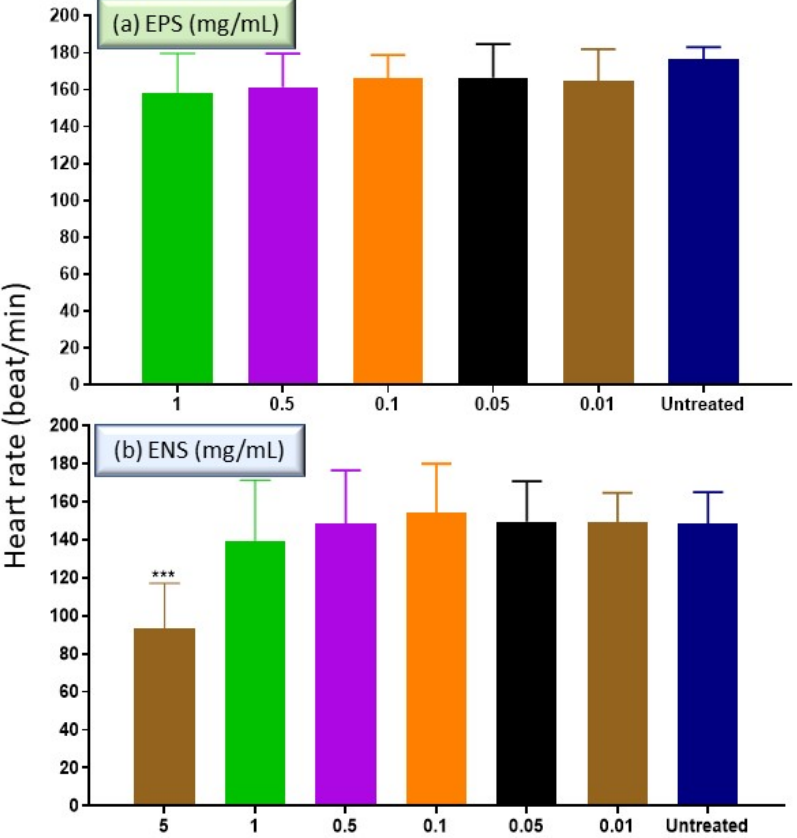
Figure 4. Effect of Ganoderma applanatum EPS and ENS extract at concentrations of 0.01–1.0 mg/mL on heart rate of zebrafish embryos at 96 HPF. For ( a ) EPS, no data at concentrations >5.0 mg/mL due to embryo death. Meanwhile, ( b ) for ENS, no data at concentrations 10.0 mg/mL recorded due to embryo death. *** p < 0.05 significantly different from the untreated group (zebrafish embryos in medium only).